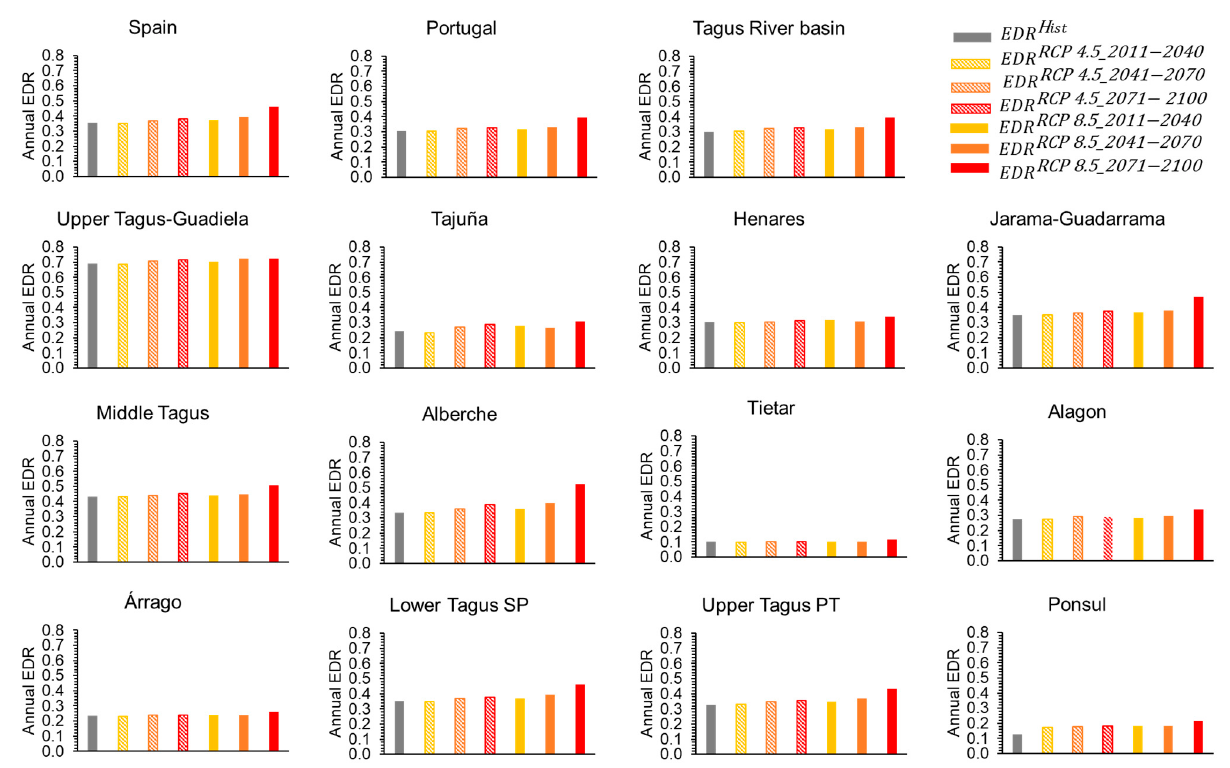
Figure 6. The comparison of annual EDR for historical records and annual EDR for near, mid and far future horizons under RCP 4.5 and RCP 8.5. Table 1. Reliability of urban supply under future scenarios.